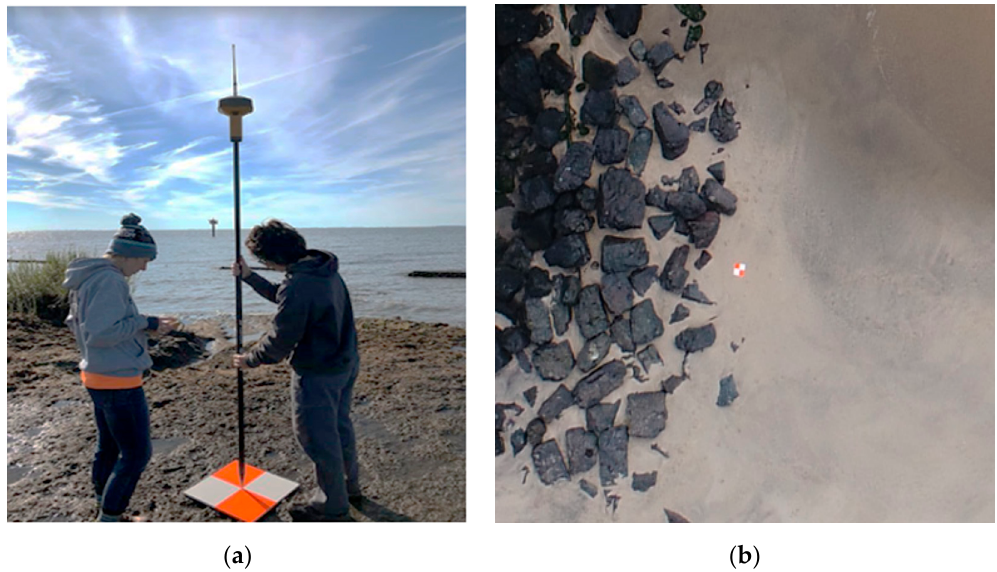
Figure 5. Examples of ground control points ( a ) Surveying the ground control point (GCP) position using an RTK GPS spot measurement system; ( b ) A typical view of a GCP from an UAS aerial image.